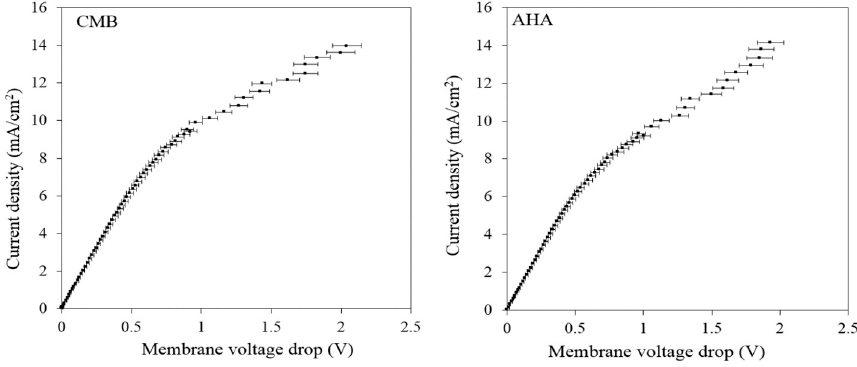
Figure 9. The current-voltage curve for a solution of 2.5 g/L KCl and 1 g/L lactic acid.